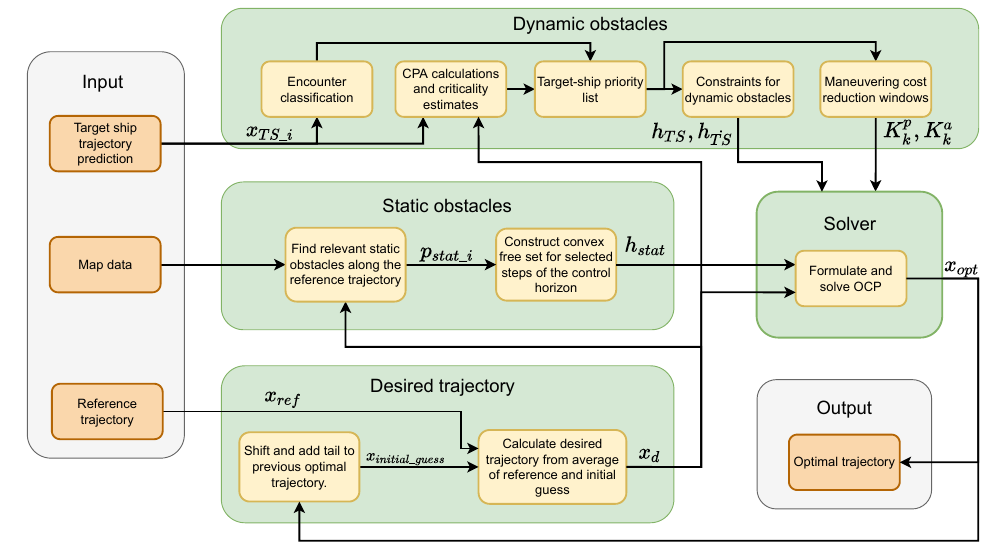
Figure 7: Overview of the pipeline for the proposed trajectory planning